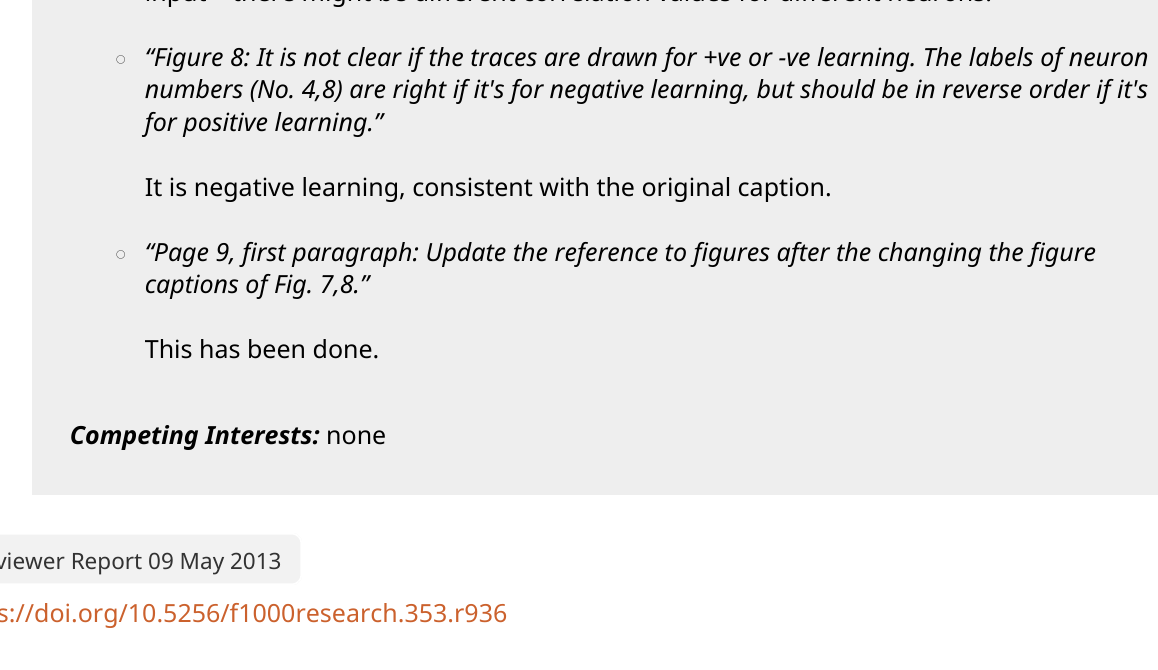
“Figure 8: It is not clear if the traces are drawn for +ve or -ve learning. The labels of neuron numbers (No. 4,8) are right if it's for negative learning, but should be in reverse order if it's for positive